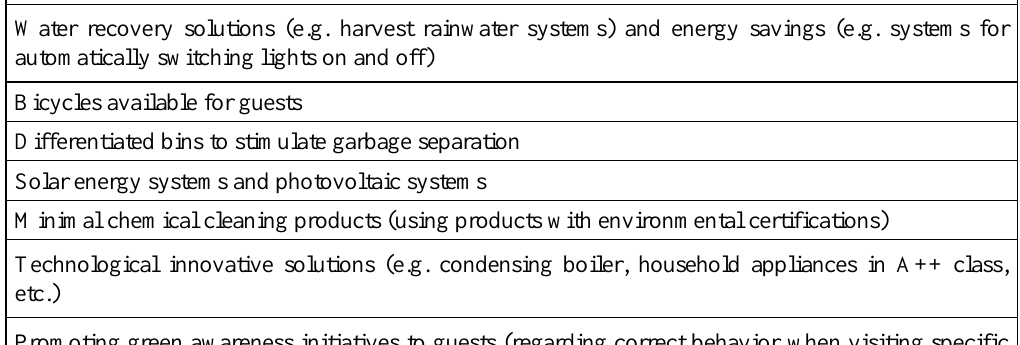
Table 1: Good Practices for Sustainability - Examples Requesting that hotel guests use towels multiple times (and leaving them on the floor when dirty) Water recovery solutions (e.g. harvest rainwater systems) and energy savings (e.g. systems for automatically switching lights on and off) Bicycles available for guests Differentiated bins to stimulate garbage separation Solar energy systems and photovoltaic systems Minimal chemical cleaning products (using products with environmental certifications) Technological innovative solutions (e.g. condensing boiler, household appliances in A++ class, etc.)